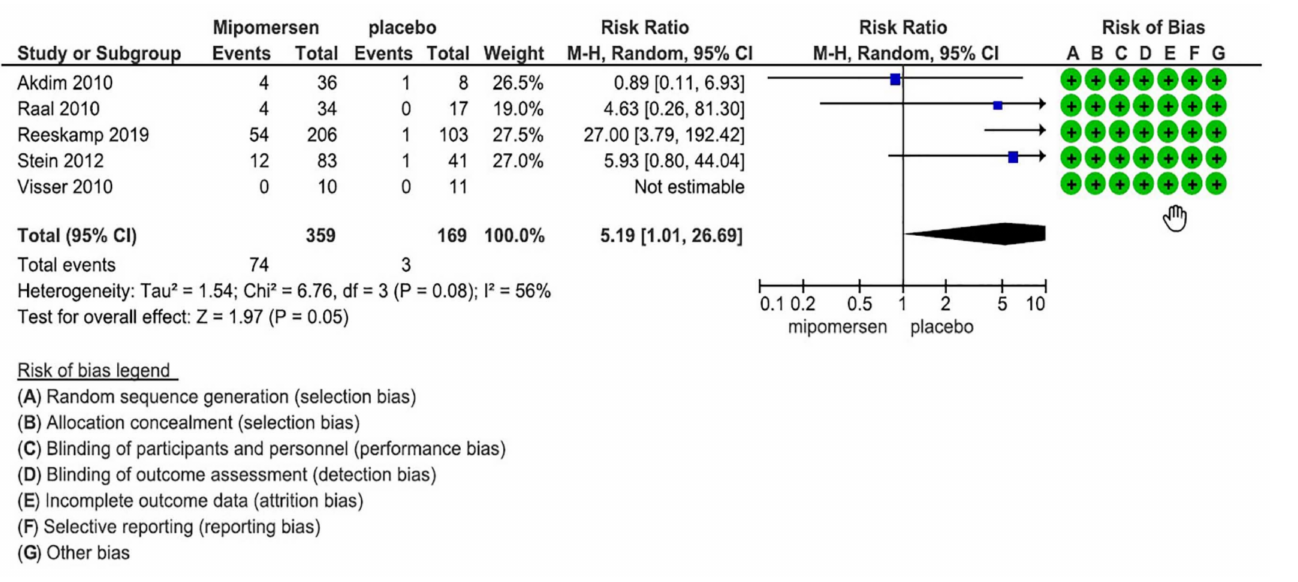
Figure 6. Forest plot for increased